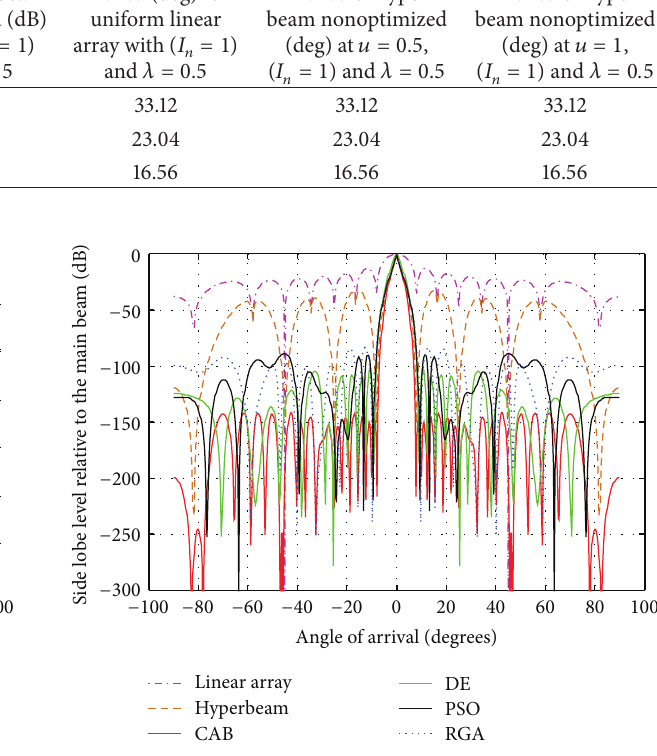
Figure 6: Best array pattern found by CAB for the 20-element array with improved SLL and FNBW at 𝑢 = 0.5 .